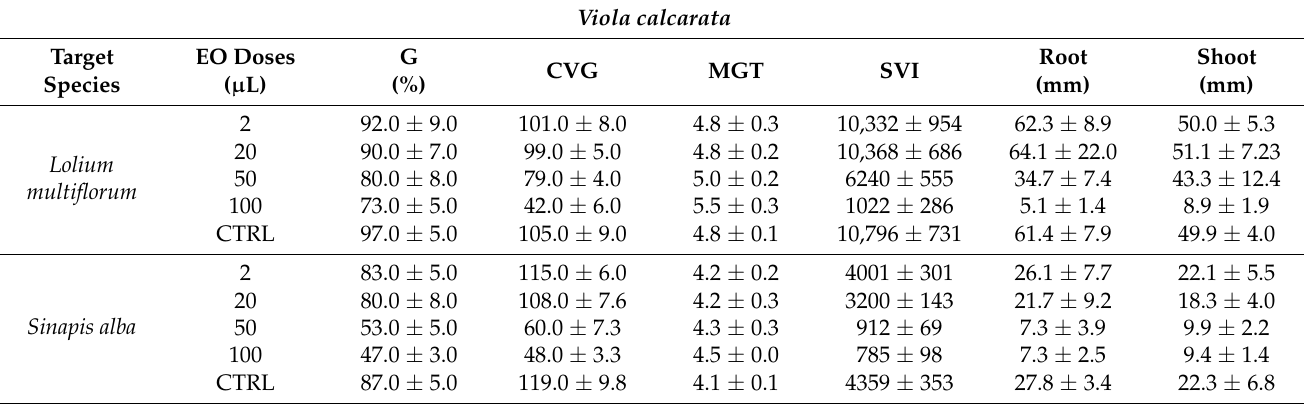
Table 3. Germination and growth parameters of two target species ( Lolium multiflorum and Sinapis alba ) under the phytotoxic effects of different doses of Viola calcarata